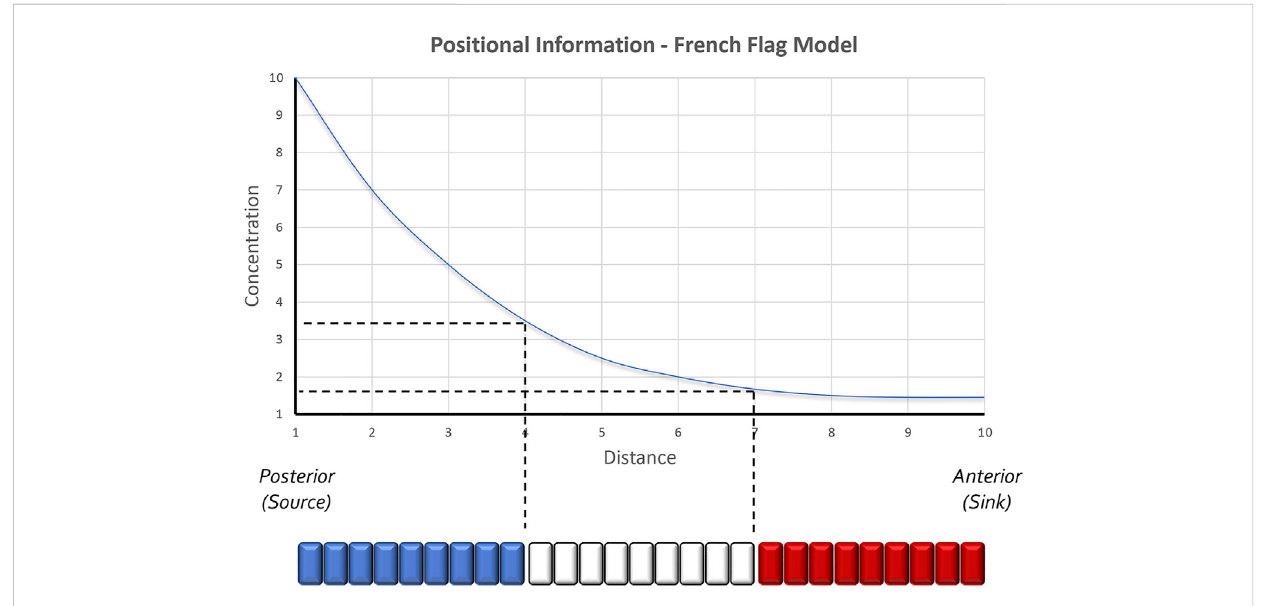
FIGURE 1 The positional information model of pattern formation. Based in part by the results of transplantation experiments conducted within the chick limb bud by John Saunders, Lewis Wolpert proposed that secreted morphogens form smooth gradients across developing tissues. Groups of cells along the gradient then capture unique amounts of the morphogen and as a result produce distinct structures. Colorized representations of this model are often represented as a French Flag where each color of the fl ag represents the conversion of a distinct morphogen concentration into a unique physical structure. Studies in the Drosophila embryo have further suggested that even 2 cells lying adjacent to each other can sense very small differences in morphogen concentrations and as a result execute different developmental programs. The schematic is adapted from Sharpe and Greene, 2015.